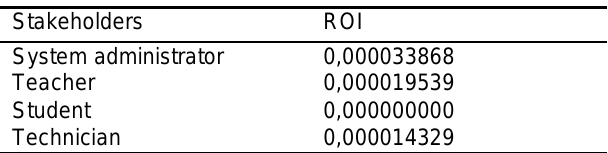
Table 17: The return on investment of the DB server Stakeholders